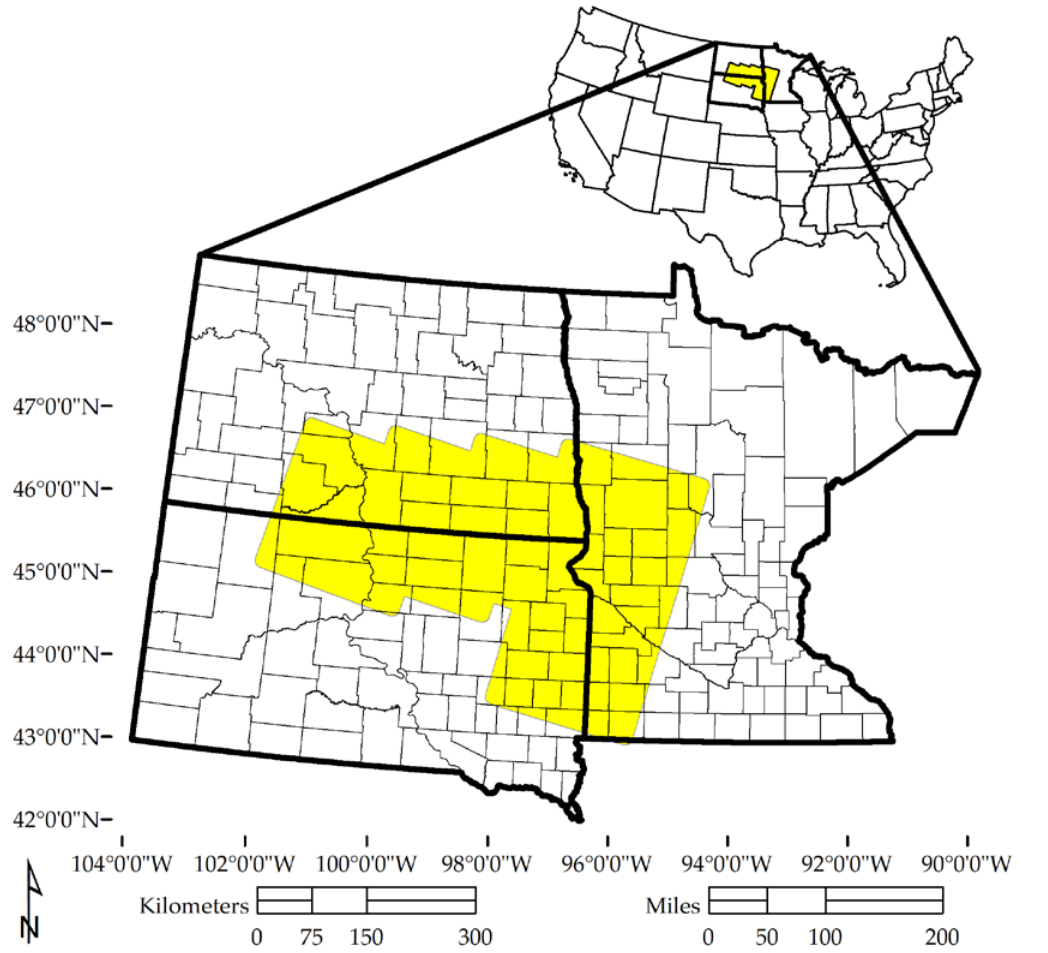
Figure 1. Location of the study area covering 150,000 km 2 in South Dakota, North Dakota, and Minnesota.